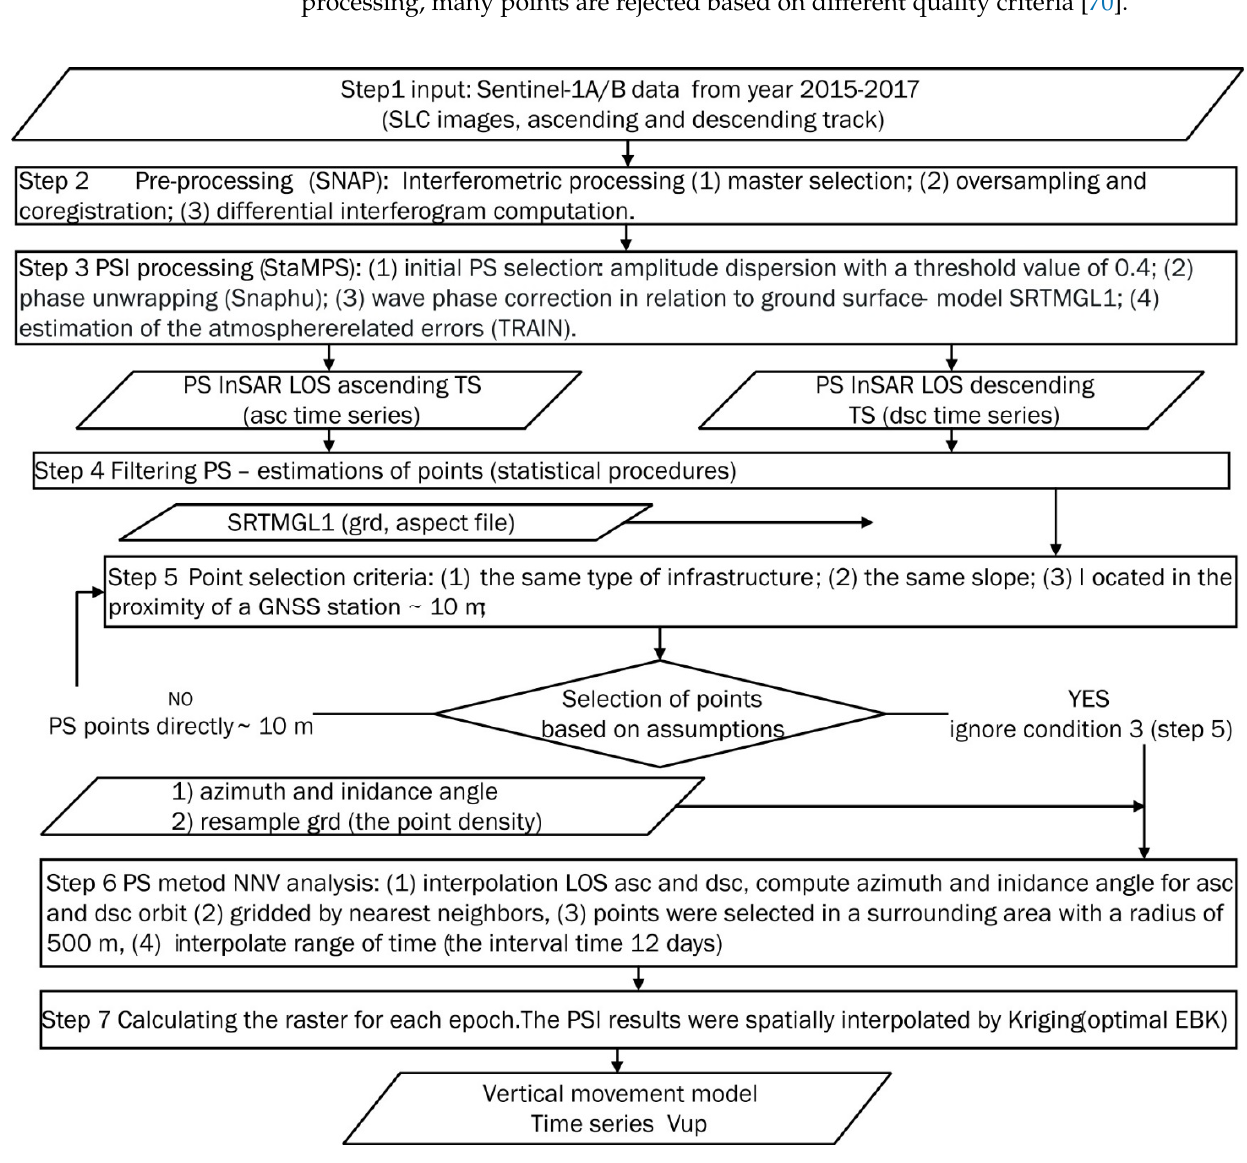
Figure 11. Workflow scheme of determining the value of vertical movement velocities in GNSS stations based on InSAR data.